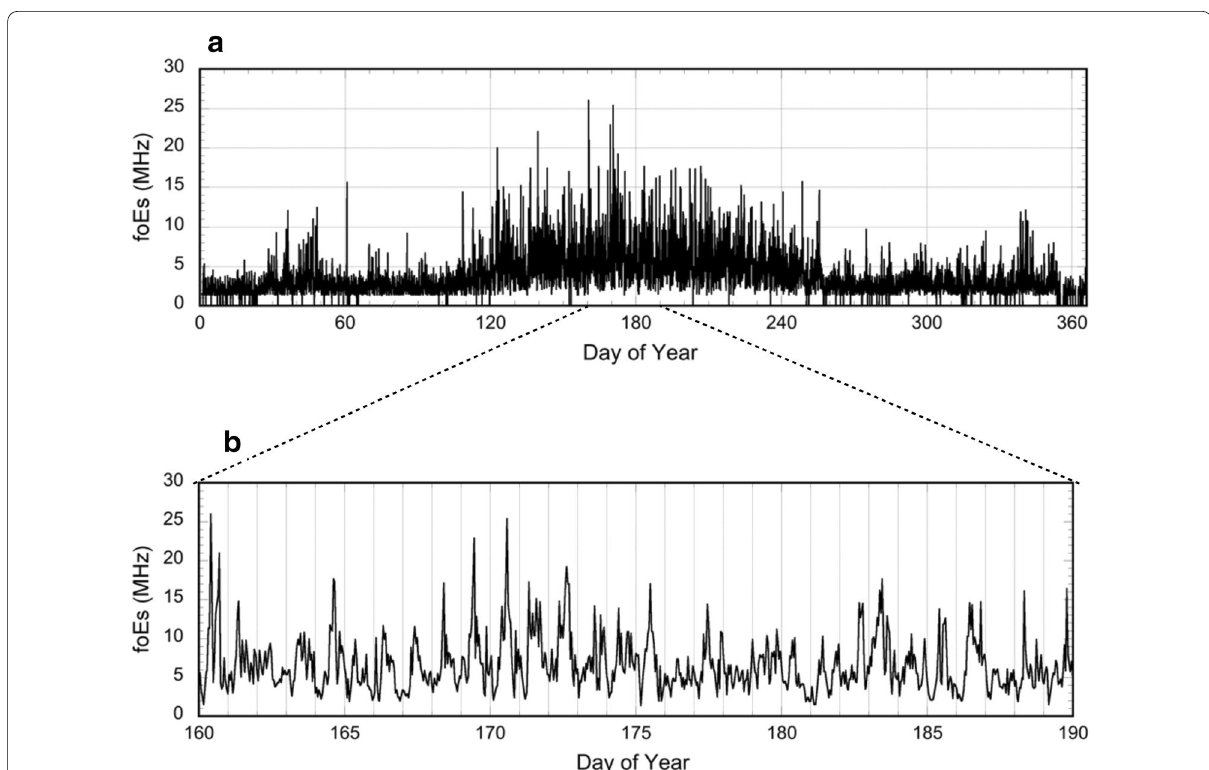
Fig. 1 Observed foEs data at Kokubunji in 2009. foEs data are obtained by the ionosonde observation at Kokubunji in 2009 for a the entire year and b the days from 160 to 190. The day of year is in Japan Standard Time (UT